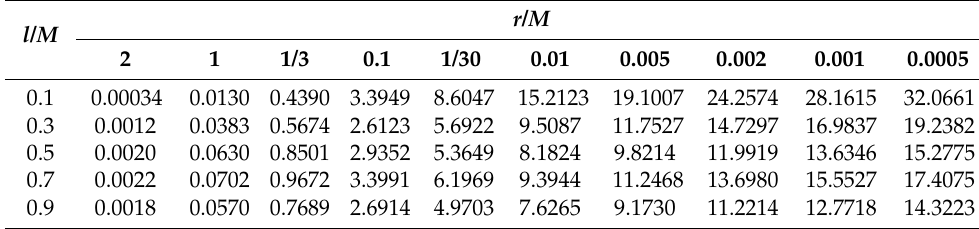
Table 2. The values of f r